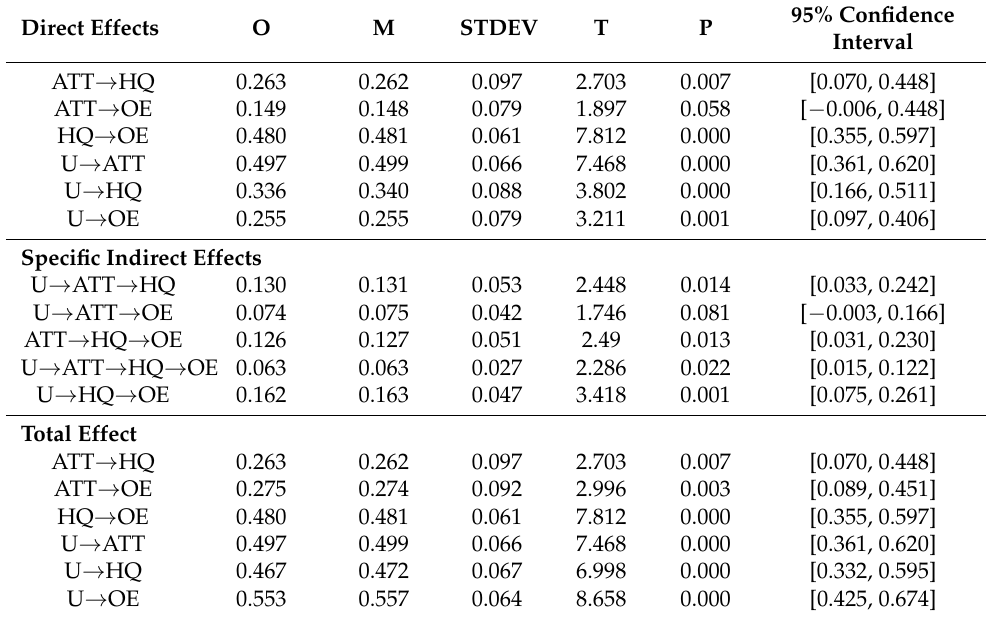
Table 5. Significance testing results of the structural model path